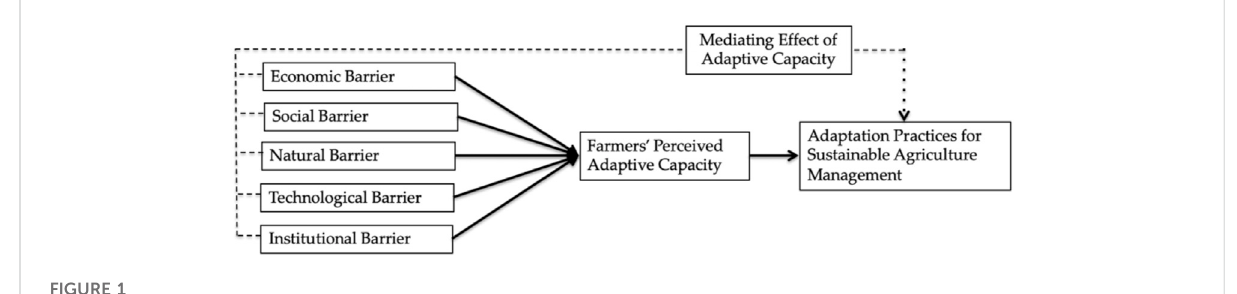
FIGURE 1 Research framework.